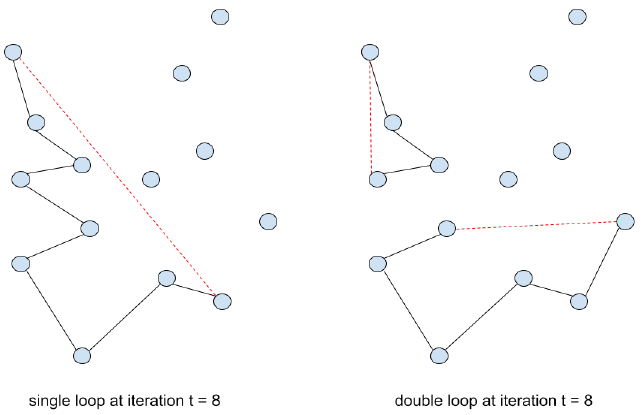
Figure A3. Single and double fragments possible inner-loops at the eighth